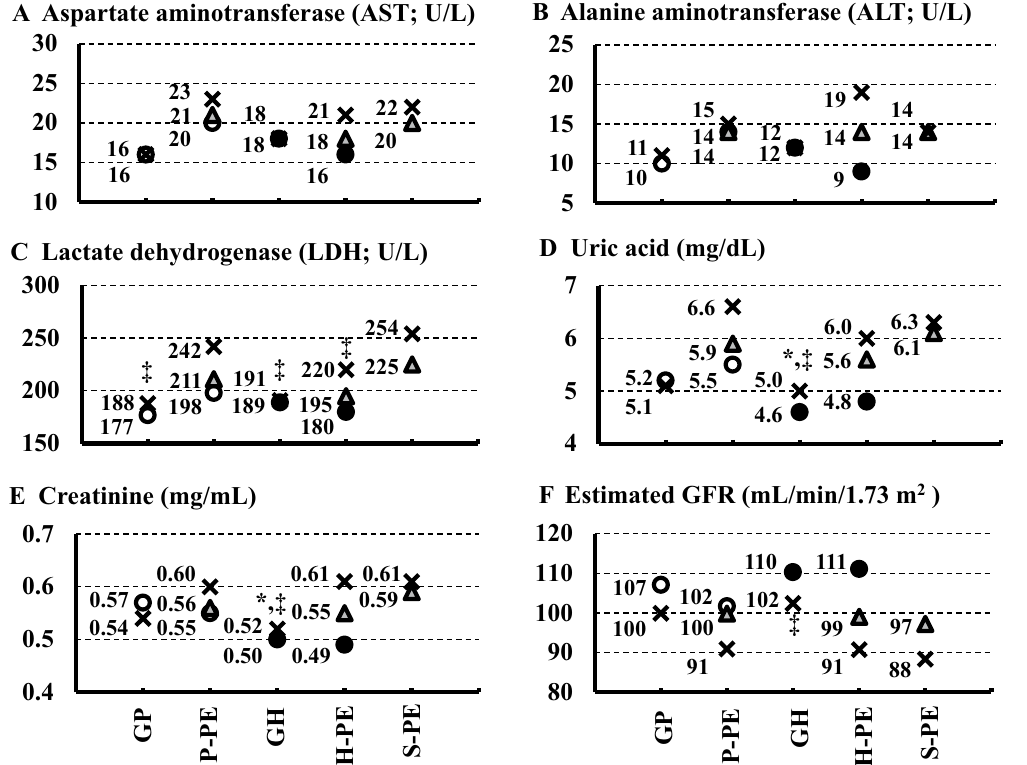
Figure 3. Trends of laboratory findings at onset of gestational proteinuria (GP) or gestational hypertension (GH), onset of preeclampsia, and delivery: aspartate aminotransferase (AST; A ) alanine aminotransferase (ALT; B ), lactate dehydrogenase (LDH; C ), uric acid ( D ), creatinine ( E ), and estimated glomerular filtration rate (GFR; F ). All data shown are median values. ○ , at GP onset (appearance of proteinuria); of hypertension); ▲ , at preeclampsia onset (hypertension plus proteinuria); ×, at delivery. *P < 0.05 versus proteinuria preceding preeclampsia (P-PE); † P < 0.05 versus hypertension preceding preeclampsia (H-PE); ‡ P < 0.05 versus simultaneous onset of proteinuria and hypertension before preeclampsia (S-PE); § P < 0.05 versus